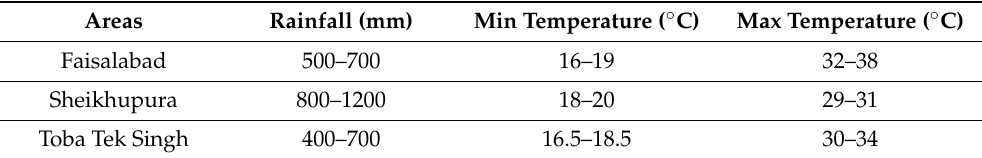
Figure 11. Historical trend of rainfall ( right ), minimum temperature ( center ), and maximum temperature ( left ) in highly stressed areas. Table 4. Summary of climatic parameters in highly stressed